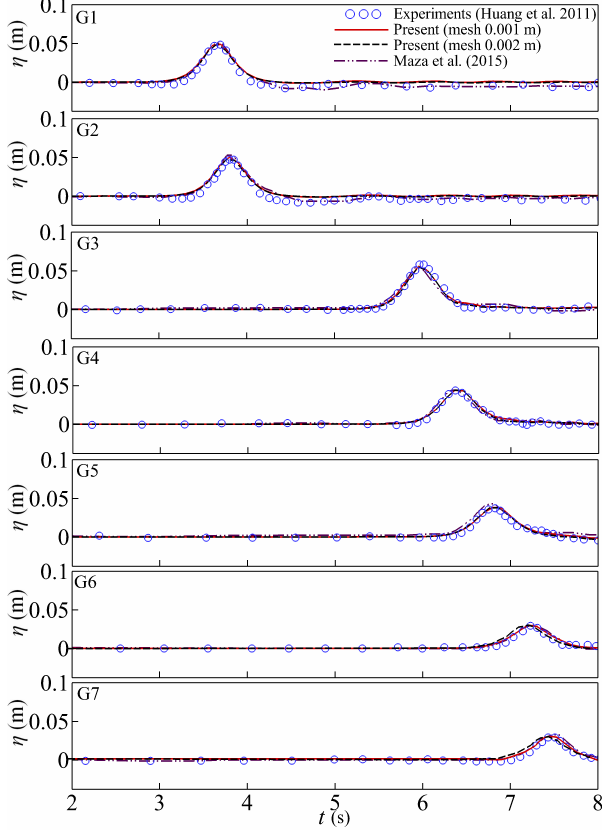
Figure 3. Comparison of free-surface evolution between numerical and experimental using field length of 1.635m and H i =